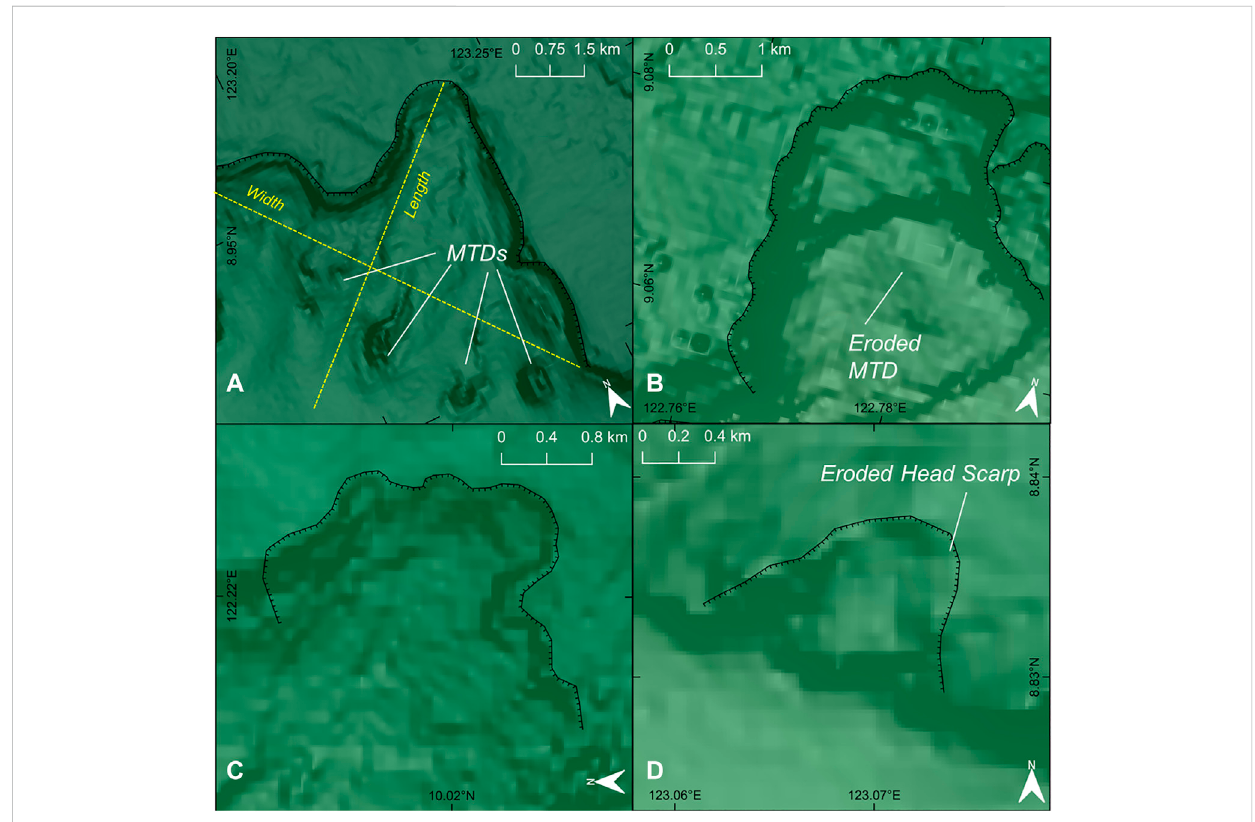
FIGURE 2 Landslide morphometric parameters (length, width, MTDs, head scarp) and con fi dence classi fi cation based on Watson et al. (2020). (A) Category 1: well-de fi ned head scarp, arcuate morphology, and MTD at the toe. (B) Category 2: well-de fi ned head scarp and arcuate morphology, eroded to no clear indication of MTDs. (C) Category 3: presence of head scarps, although eroded, and arcuate morphology. No MTDs. (D) Category 4: Heavily eroded headscarps and no MTDs but with arcuate morphology; these are mainly small submarine landslides limited by the bathymetry